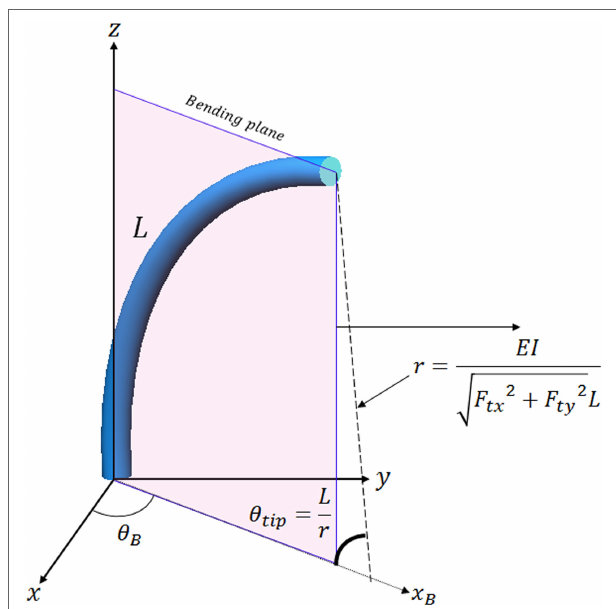
FigUre 10 | catheter tip position calculation in the bending plane using the constant curvature assumption .